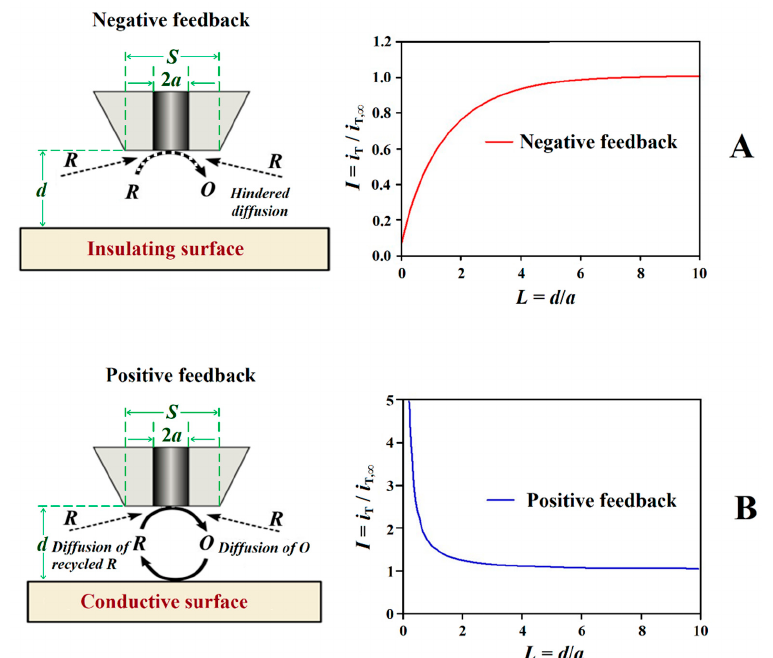
Figure 5. Schemes and shapes of Z-approach curves in the feedback mode of SECM [114]. Types of feedback: ( A ) negative and ( B ) positive.